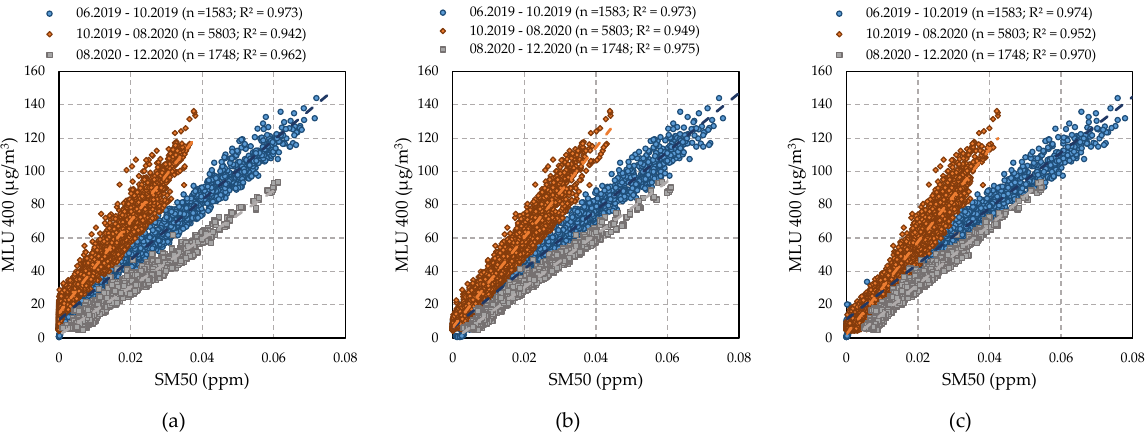
Figure 5. Results of linear fittings for 1-h averaged data from SM50: ( a ) unit No. 1, ( b ) unit No. 2, ( c ) unit No. 3. Dashed lines denote the fitted curves. n—number of samples used for the fitting, R 2 —coefficient of determination.